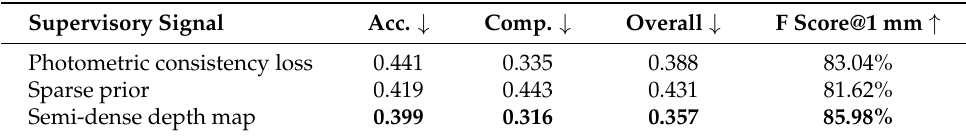
Table 7. Qualitative results of point cloud reconstruction on the DTU dataset (lower is better). The best results are in